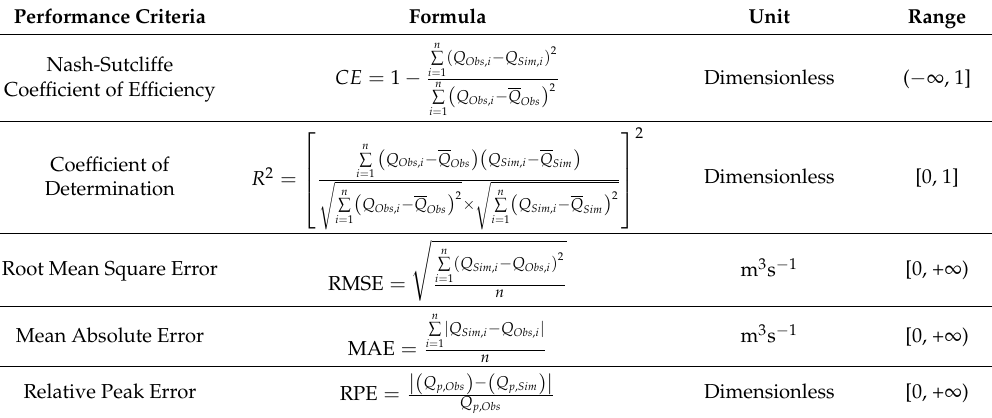
Table 2. Summary of performance criteria used to evaluate model performances.